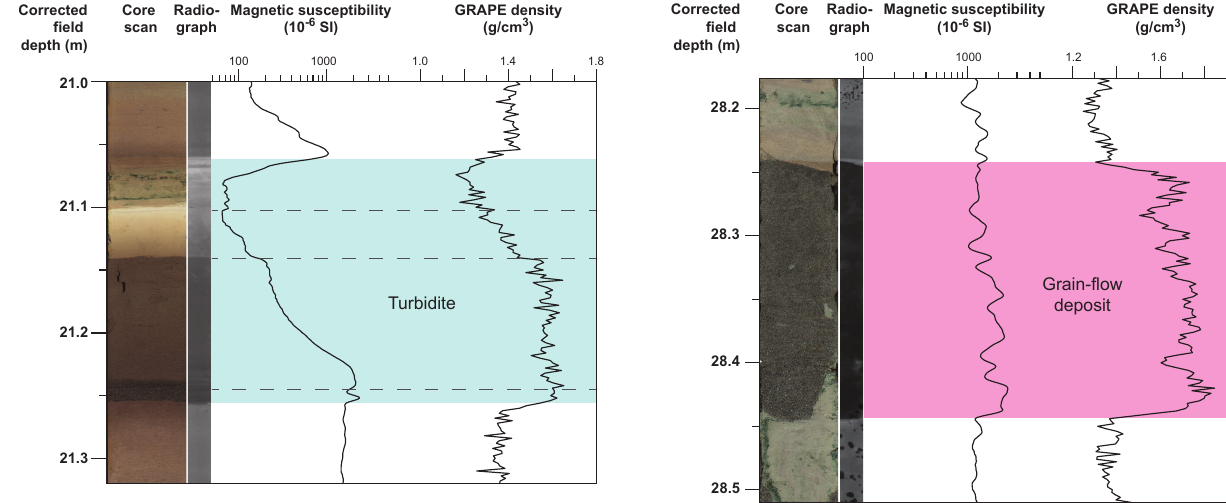
Fig. 4. Grain-flow deposit G59 (age 666ka) in a core scan from 5011-1B-8H-1. Radiograph confirms the massive nature of the de- posit. Magnetic susceptibility is somewhat higher, while density is clearly higher within the grain-flow deposit compared to pelagic